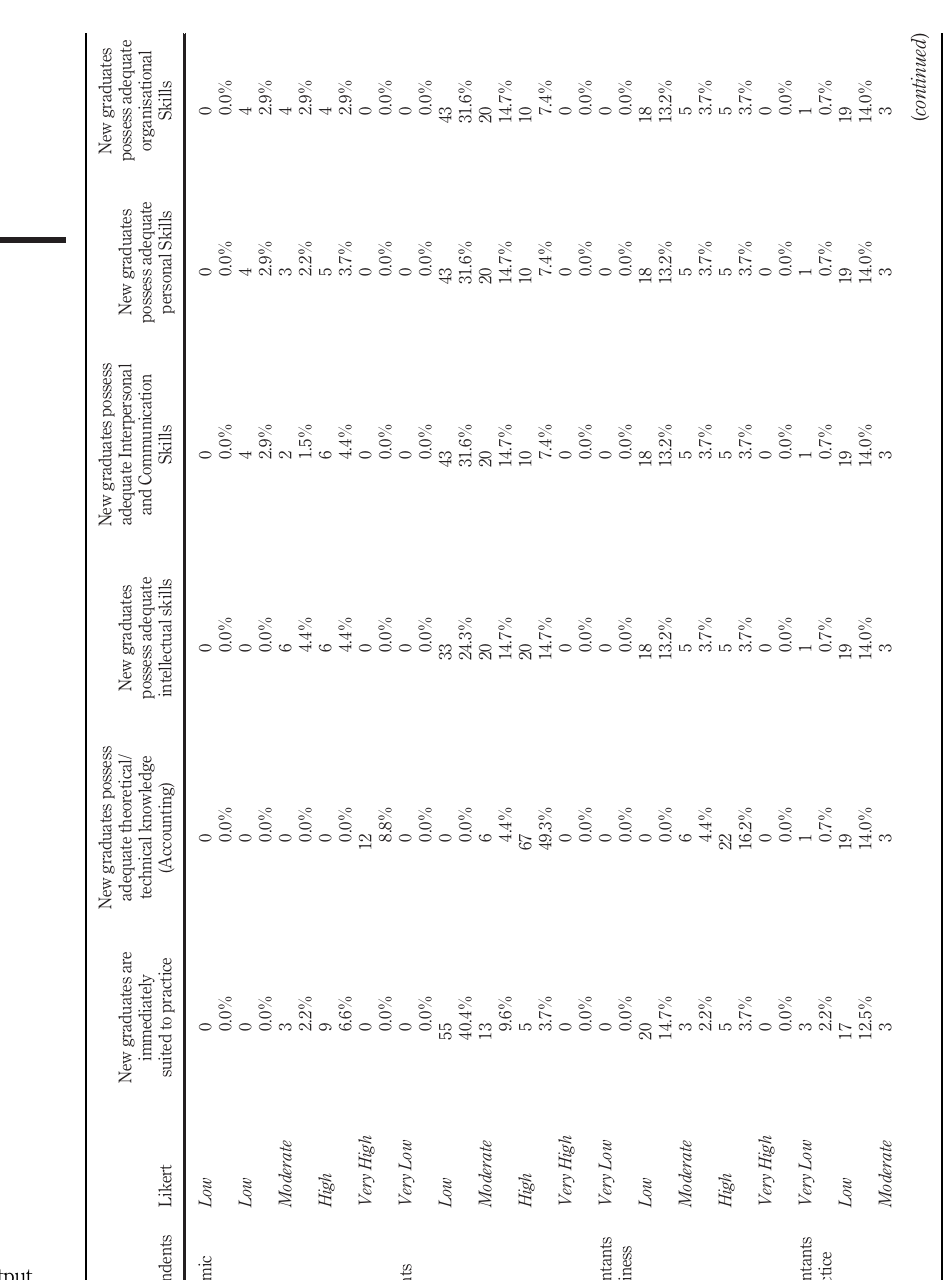
Table 8. Quality of output